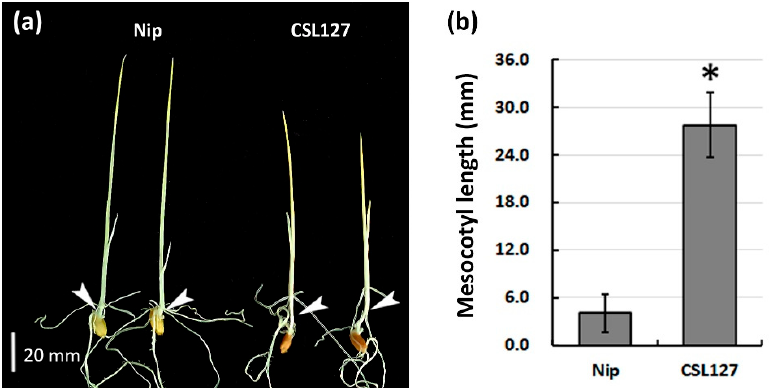
Figure 3. Comparison of ME between the Nip and CSL127 lines. ( a ) Seedlings of Nip and CSL127 after growing for 7 days in darkness. The arrows indicate the mesocotyls. Scale bar, 20 mm. ( b ) Mesocotyl length. The values are the means ± SD of 12 seedlings. The significance of differences between Nip and CSL127 was determined by Student’s t test (*, p < 0.01).